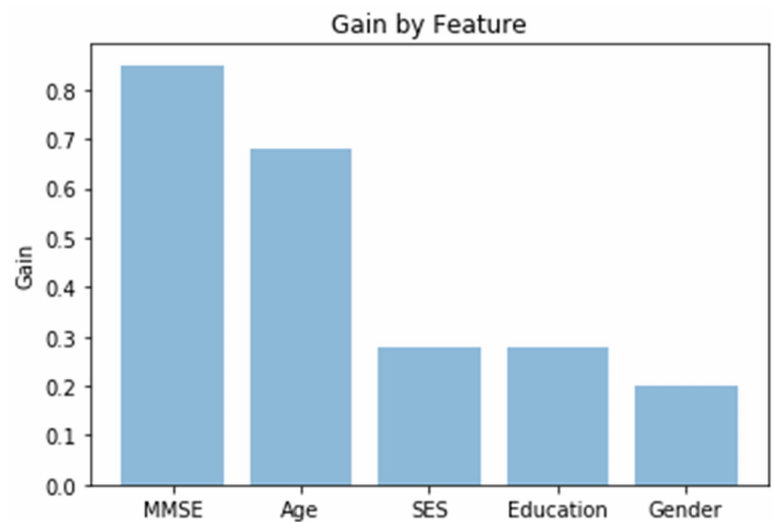
Figure 7. Variable importance. SES - socioeconomic status.